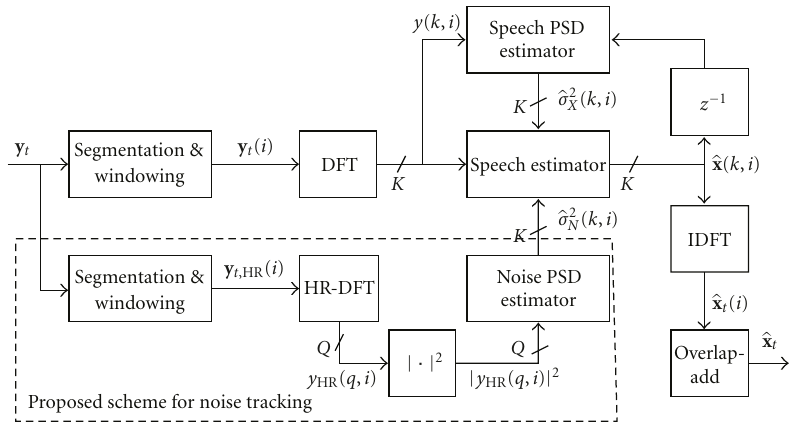
Figure 1: Overview of a DFT-domain-based noise reduction system with the proposed noise PSD tracking